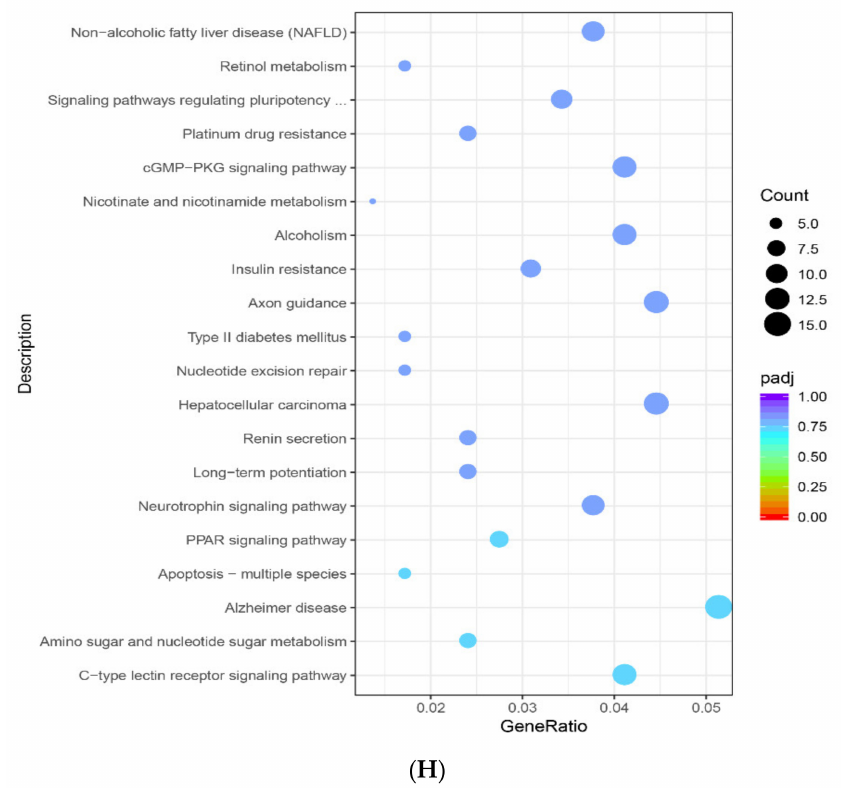
Figure 4. KEGG enrichment analysis of DEGs in the down-regulated DEGs ( A , C ) and up-regulated DEGs ( B , D ) of group 1 (LPS vs. Control) and group 2 (TAK vs. LPS) (( E , G ) for down-regulated DEGs and ( F , H ) for up-regulated DEGs). The abscissa indicated the ratio of DEGs, which annotated the KEGG items to all